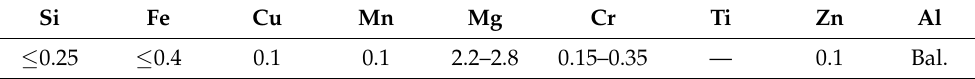
Table 1. Chemical compositions of the 5052 aluminum alloy (mass fraction/%).